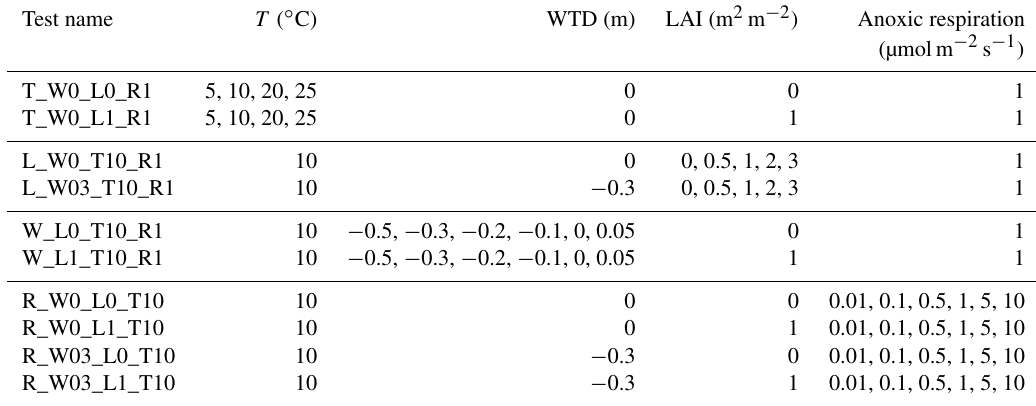
Table 2. Summary of the steady-state sensitivity tests in which response of HIMMELI to different input combinations was analyzed.